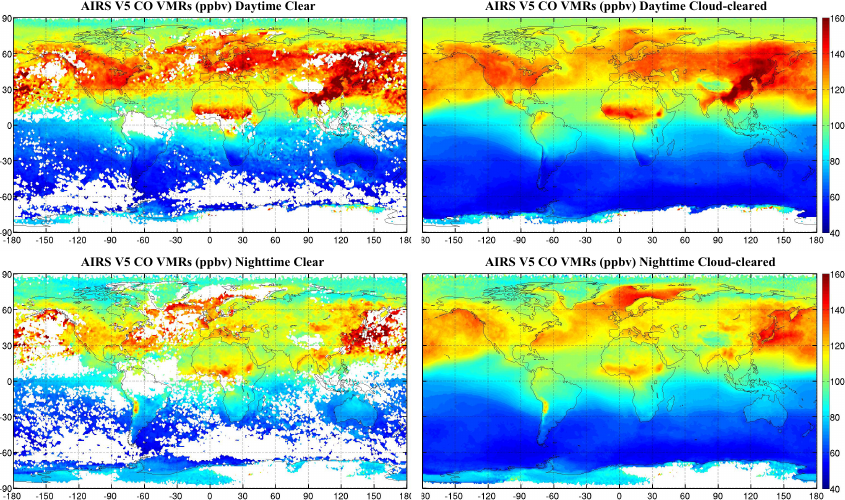
Fig. 3. The 3-month mean AIRS V5 CO VMRs (ppbv) at 500hPa for March to May 2006, showing the clear sky daytime cases (upper left Figure 3. The three-months mean AIRS V5 CO VMRs (ppbv) at 500 hPa for March to May 2006 with the clear sky daytime cases (left upper panel), the clear sky nighttime cases (left bottom panel), the cloud-cleared daytime cases panel), the clear sky nighttime cases (bottom left panel), the cloud-cleared daytime cases (upper right panel), and the cloud-cleared nighttime (right upper panel), and the cloud-cleared nighttime cases (right bottom panel). cases ( bottom right